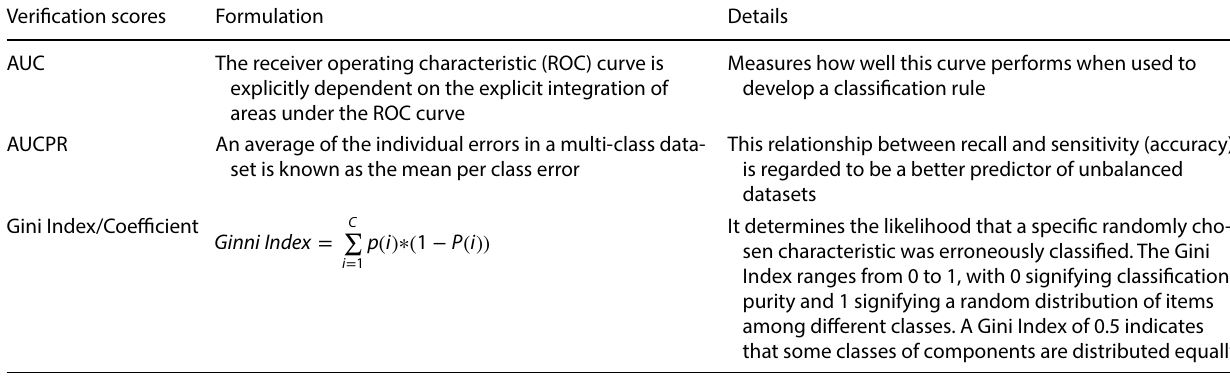
Table 2 List of verification scores used in the study Verification scores